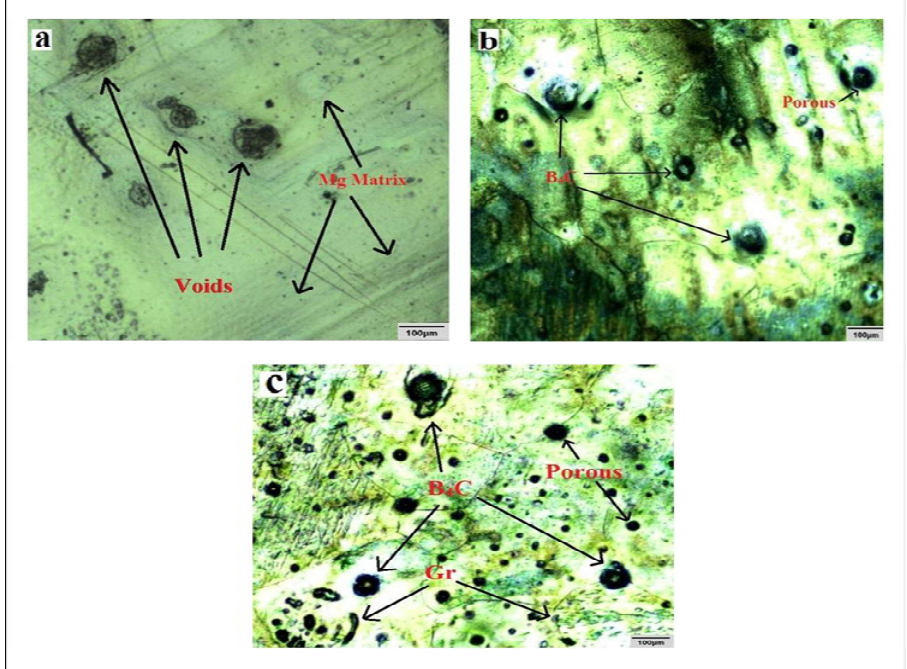
Fig. 4. Optical micrographs of the produced composites: (a) AZ91D, (b) AZ91D/1.5% B B C /1.5%Gr, reprinted with permission from I. Aatthisugan, A.R. Rose and D.S. Jebadurai // J. Magnes. 4 Alloys 5(2017)20, under the CC BY-NC-ND 4.0 license (http://creativecommons.org/licenses/by-nc-nd/